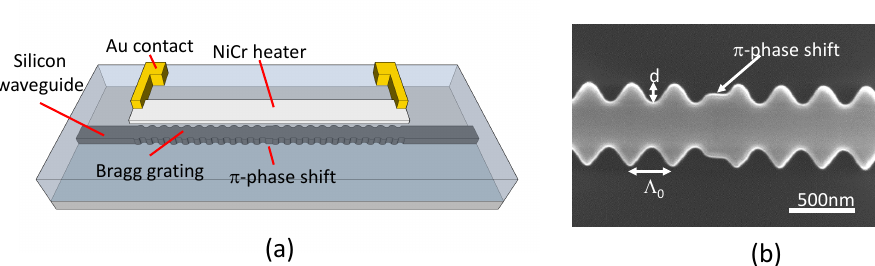
Figure 2. ( a ) Schematic of a silicon π -phase shifted grating with resistive heating element for wavelength tuning and thermal stabilization; ( b ) Scanning Electron Microscope (SEM) image of the phase shift section at the centre of a grating device (a device with d = 70 nm is shown to best illustrate the grating modulation